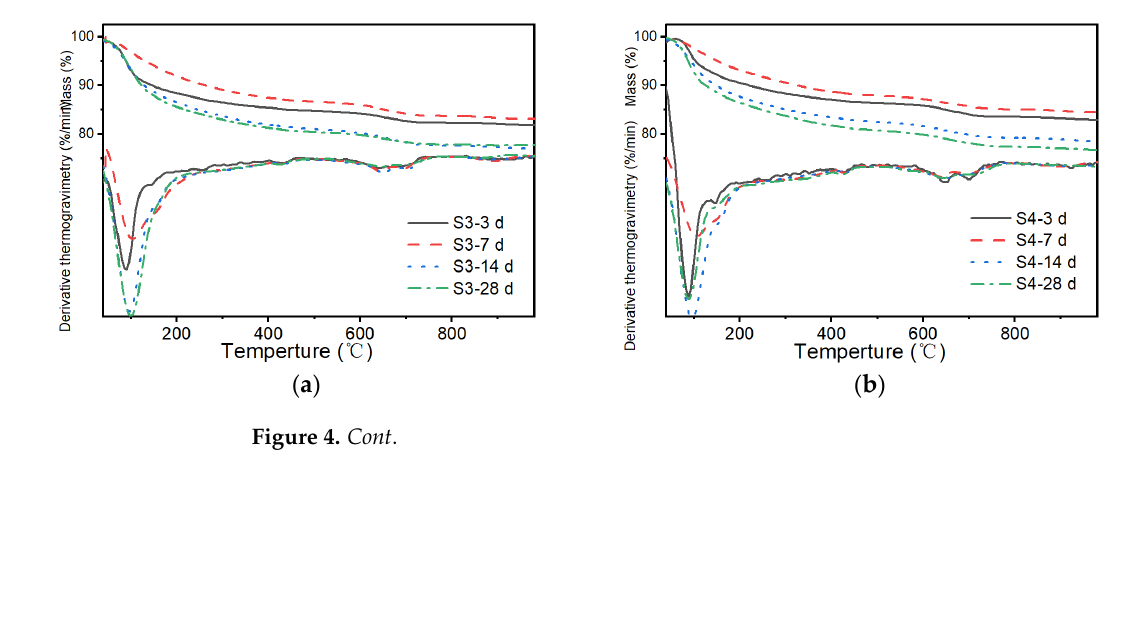
Figure 3. X-ray diffraction (XRD) patterns at different ages for samples ( a ) S3, ( b ) S4, and ( c ) S5, and ( d ) those of different samples at 28 days.